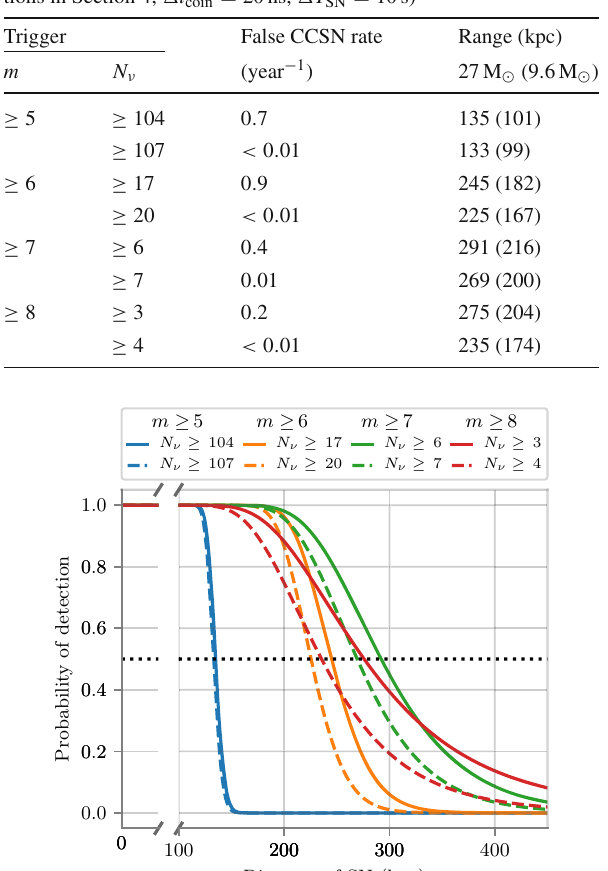
Table 4 False CCSN detection rate and range of supernova detection (50% probability) for different values of m and N ν (see trigger condi- tions in Section 4; (cid:5) t coin = 20ns, (cid:5) T SN = 10s)